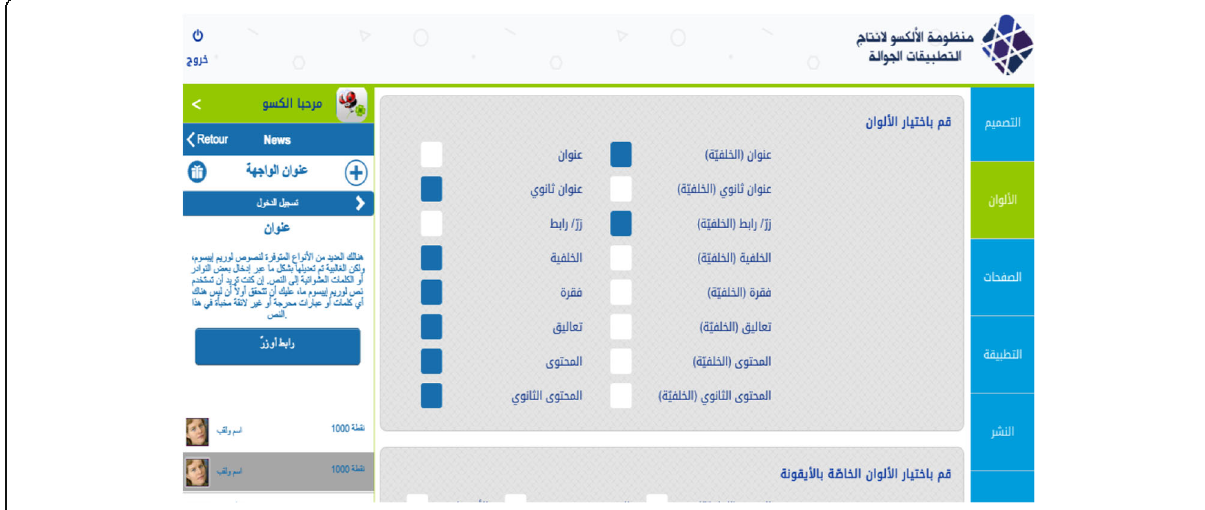
Fig. 3 Creation of mobile applications intuitively in few